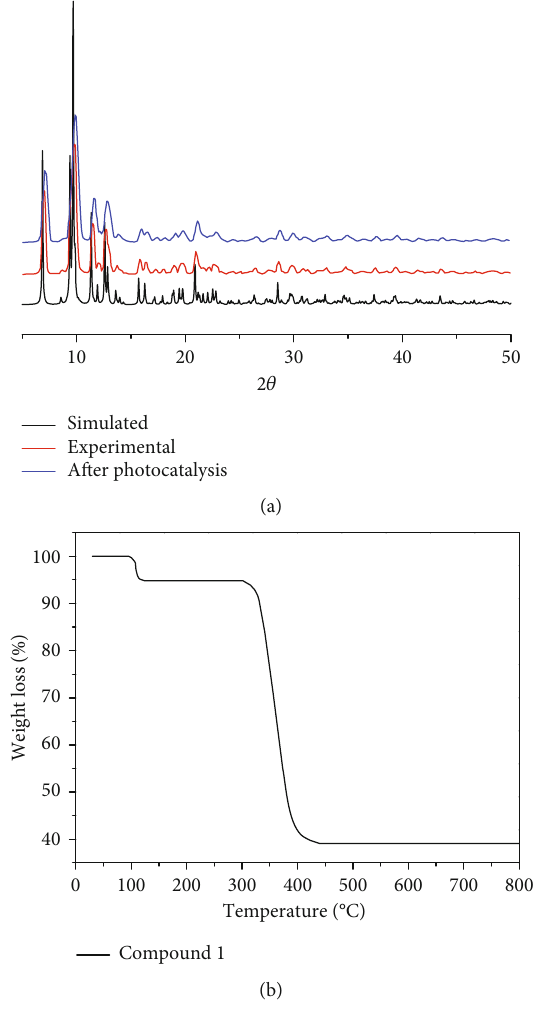
Figure 1: (a) Powder X-ray di ff raction patterns for 1 . (b) The TGA curve for 1